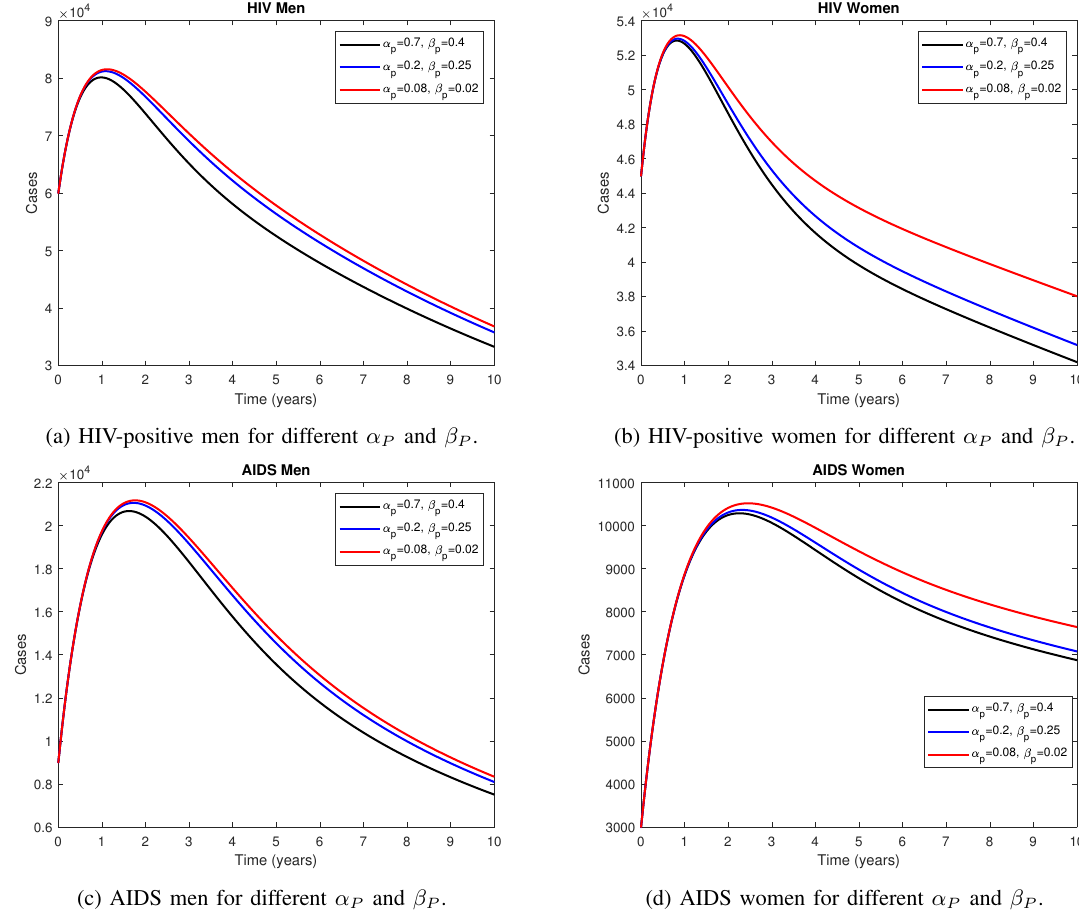
Fig. 10: Study of the joint variations of the HIV and AIDS compartments for men and